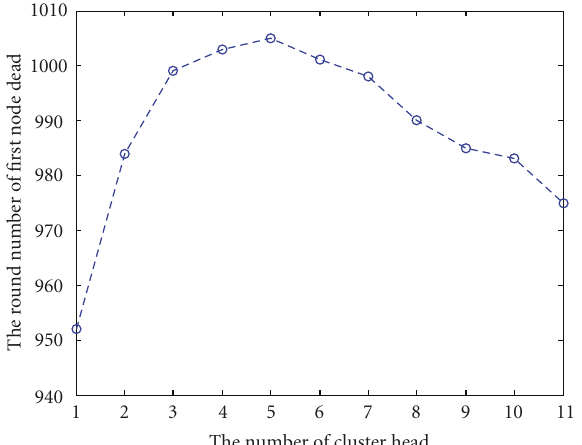
Figure 3: The dead radar node round via cluster head number.